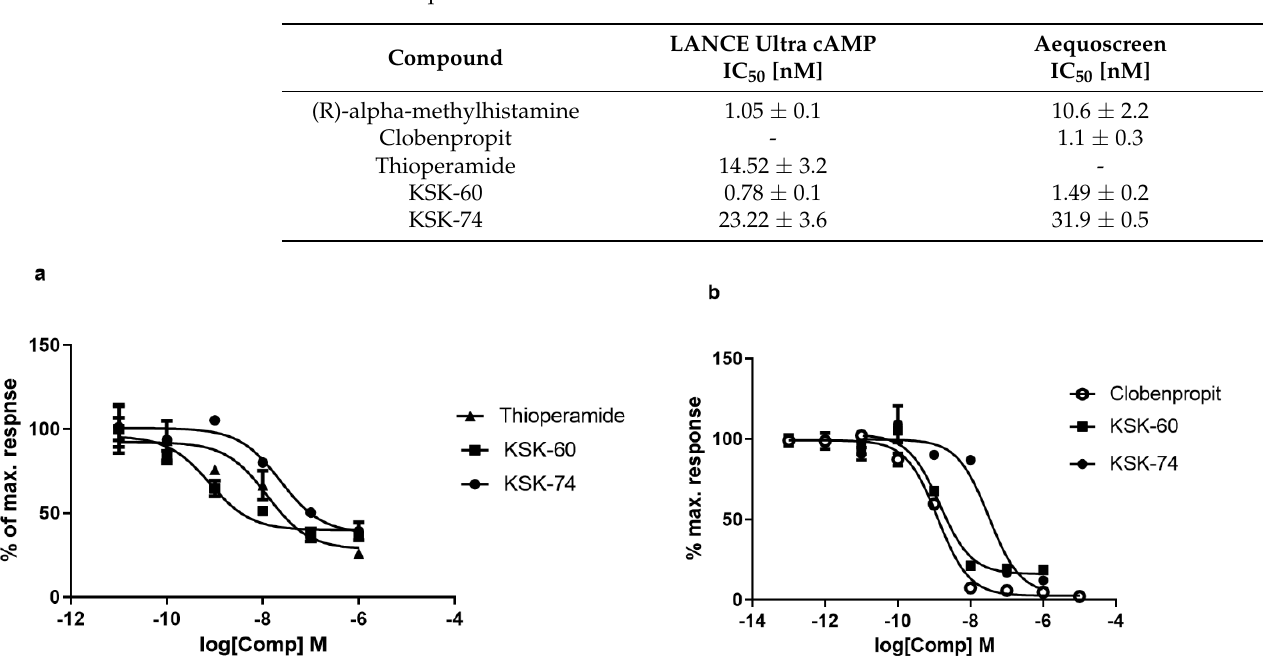
Table 1. The IC 50 values for the antagonist dose–response with the reference agonist ((R)-alpha- methylhistamine) at a final concentration equivalent to EC 80 obtained by two methods: LANCE Ultra cAMP and Aequoscreen.